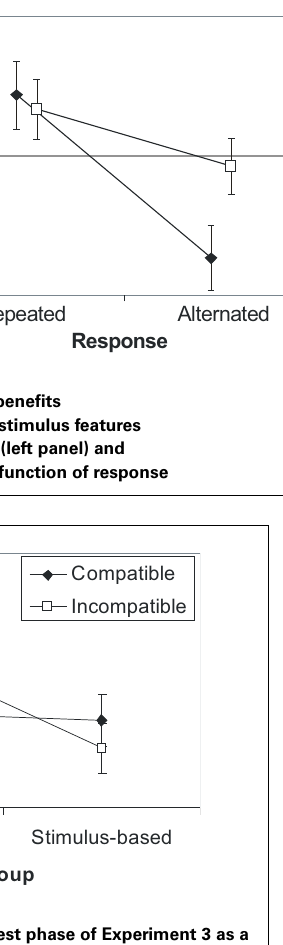
FIGURE 5 | Mean reaction times in the test phase of Experiment 3 as a function of group and compatibility. Error bars represent within-subject standard errors, calculated separately for each group (Loftus and Masson,